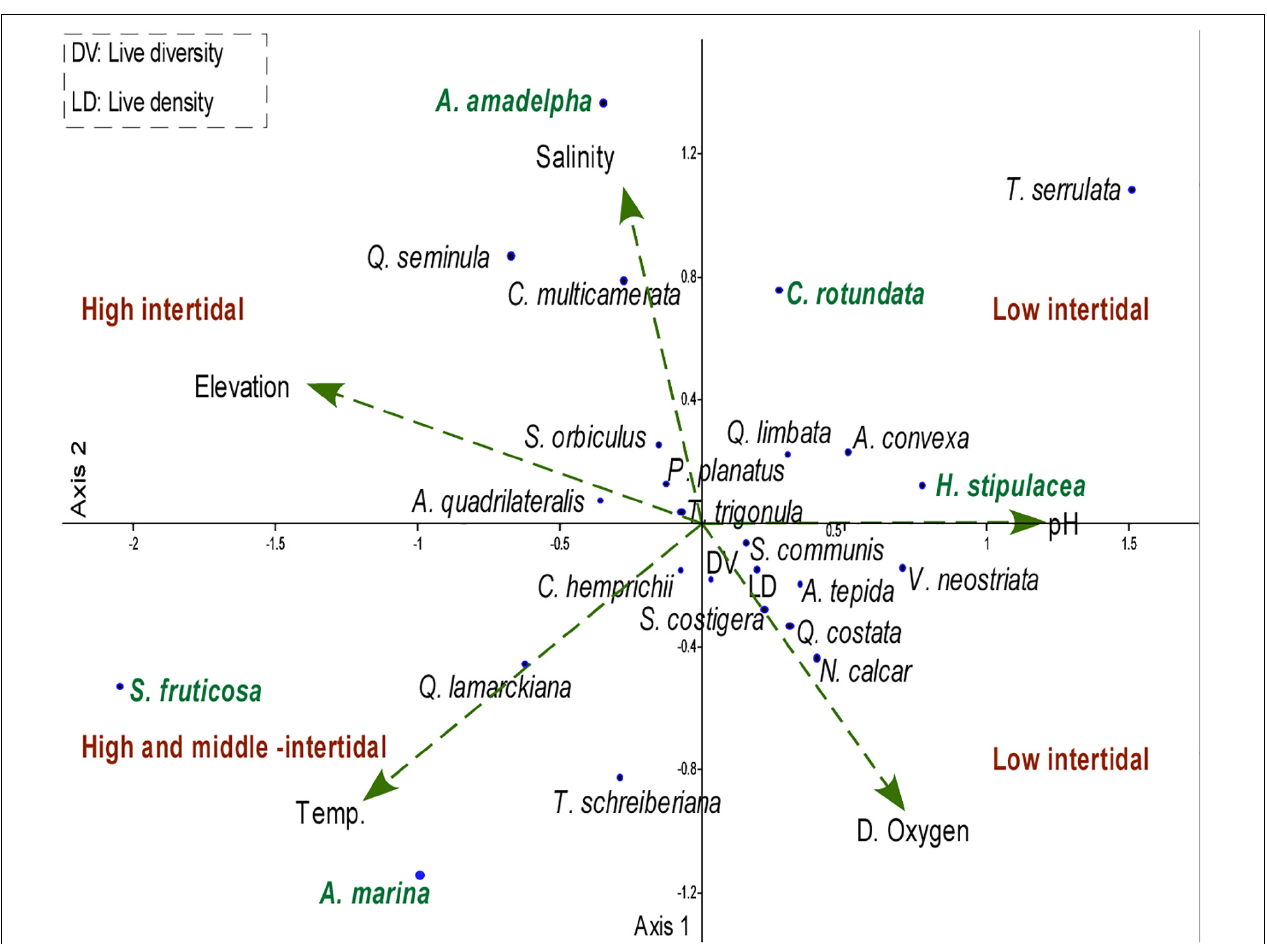
FIGURE 9 | Canonical correspondence analysis (CCA) showing the relationship between of foraminiferal assemblage, density, diversity, intertidal zones and environmental variables (arrows) such as elevation, temperature, salinity, DO, pH in KL.